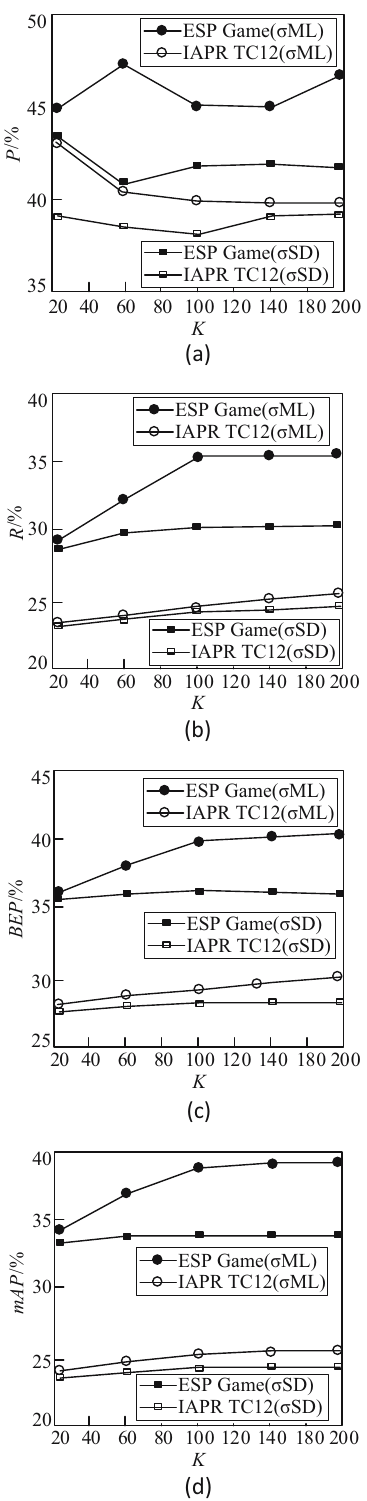
Figure 4: Relationship between neighbor size K and based on the distance model variants of performance of σ SD and σ ML in terms of P , R , BEP, and mAP: ( a ) P versus the number of neighbors, ( b ) R versus the number of neighbors, ( c ) BEP versus the number of neighbors, and ( d ) mAP versus the number of